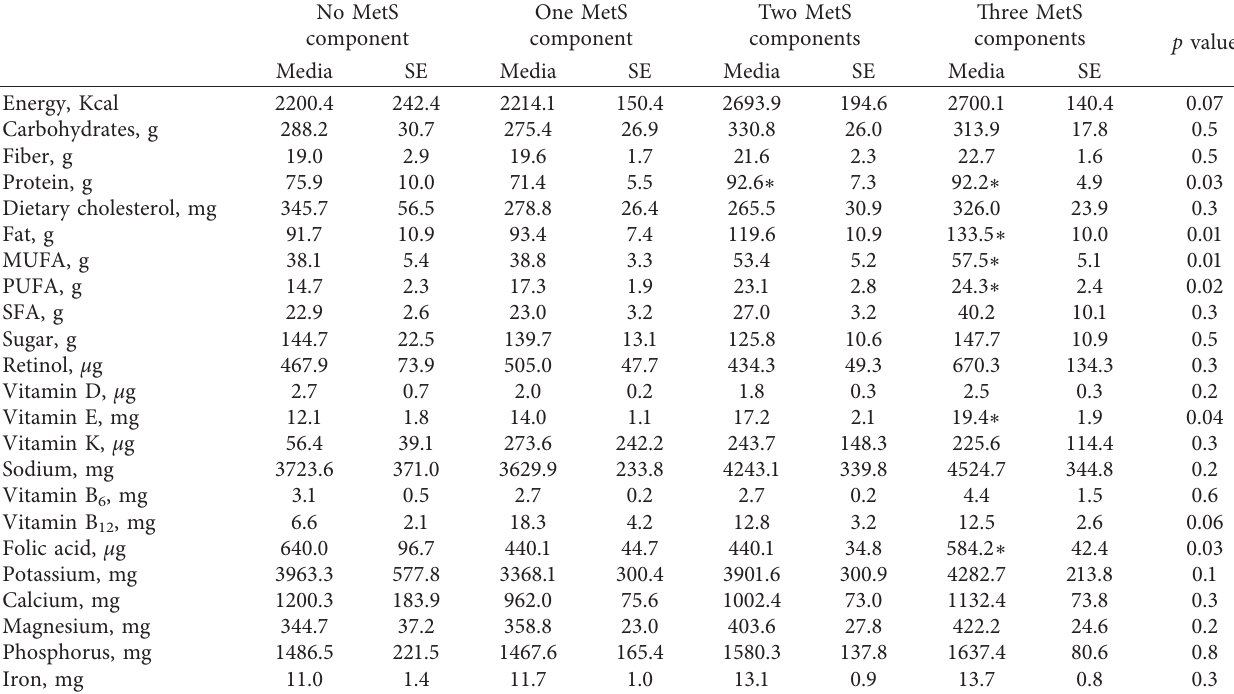
Table 4: Comparison of nutrient intake by patients with different number of metabolic disorders.